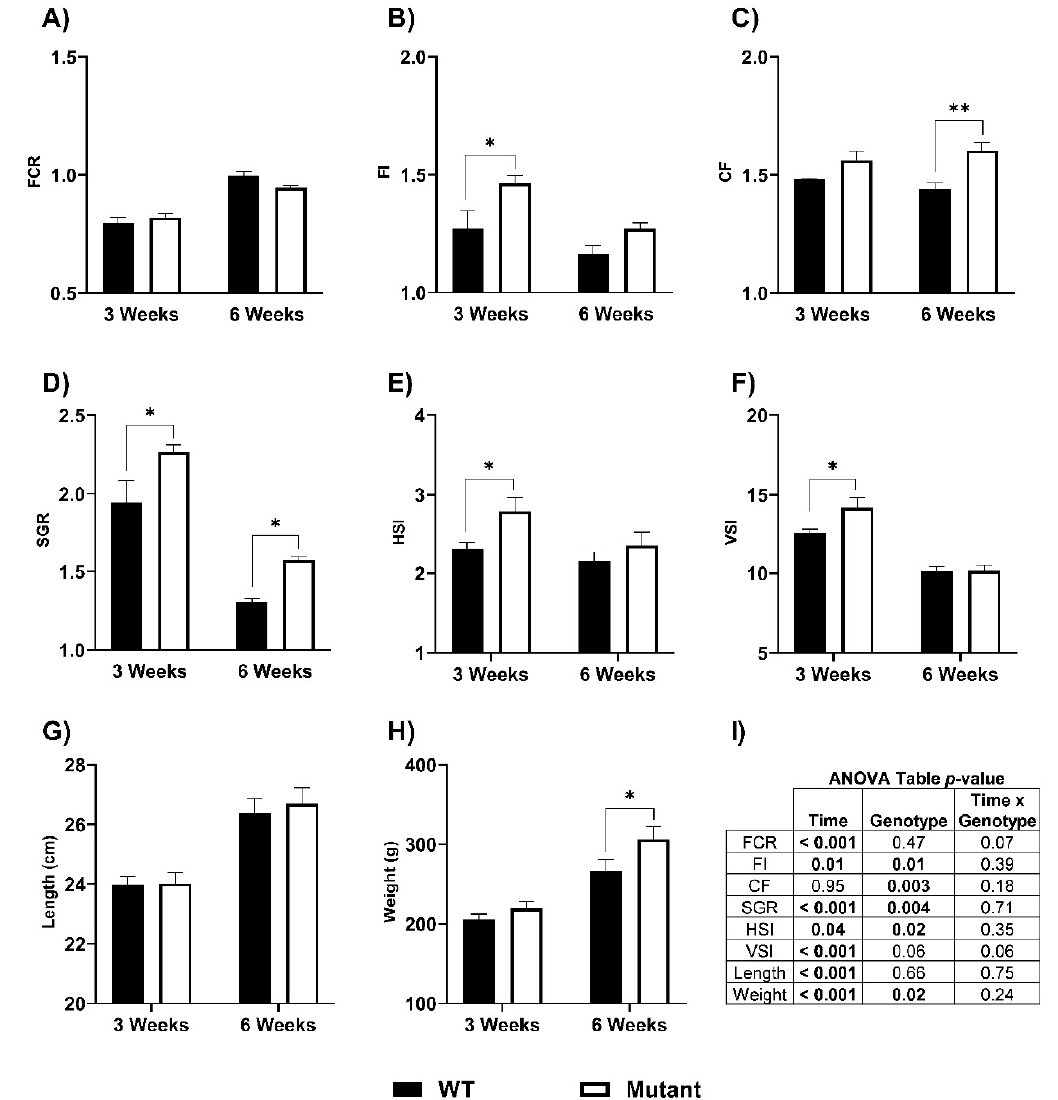
Figure 3. Growth and feeding responses of WT and LepR mutant rainbow trout that were fed to satiation for six weeks. ( A ) feed conversion ratio (FCR), ( B ) feed intake (FI), ( C ) condition factor (CF), ( D ) specific growth rate (SGR), ( E ) hepatosomatic index (HSI), ( F ) viscerosomatic index (VSI), ( G ) length (cm), ( H ) weight (g), and ( I ) ANOVA table. Values reported as means ± SEM. * denotes significant differences between WT and mutant fed fish within each time point. (* p ≤ 0.04, ** p = 0.004; HSI, VSI, length, weight, n = 13–28; FCR, FI, CF, SGR, n = 3 tanks per genotype). The significant p -values from different interactions are shown bolded in the ANOVA table in panel 3I.